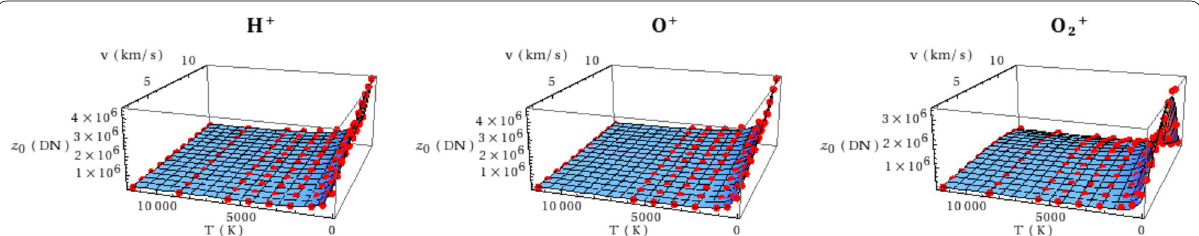
Fig. 18 Least-squares fits (blue surfaces) of EES Gaussian image model parameter z 0 (Equation C.9) to the values determined from TII MCS (red points) as a function of ion ram speed and ion temperature. TII MCS simulations were carried out for three ion species spanning the masses of the IRI model ion